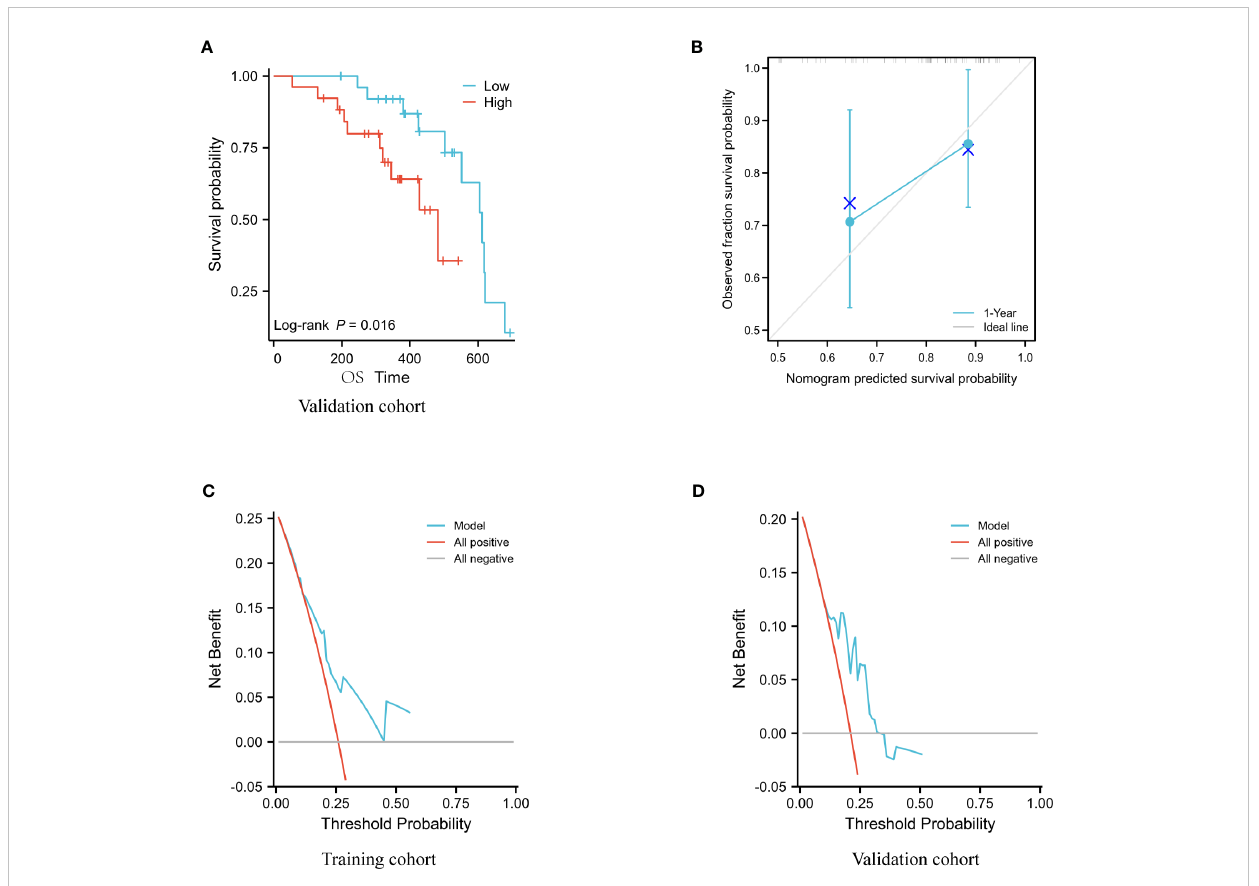
FIGURE 4 Model evaluation of the validation set. (A) Analysis using Kaplan-Meier of the association between OS and ALI in the validation cohort. (B) Validation of column line graph calibration plots for predicting 1-year OS in a group of hepatocellular carcinoma participants. (C, D) DCA analysis of the validation set and training set